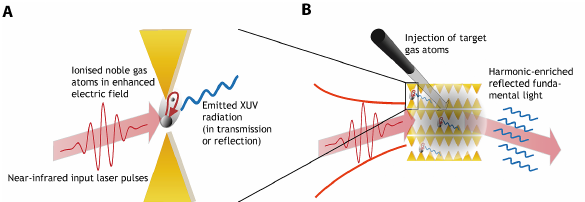
Figure 1: Scheme of HHG aided by plasmonic field enhancement (after [29]). a , An incident, near-infrared ultrashort laser pulse ex- cites a plasmon inside a bow-tie nano-antenna. Noble gas atoms, as commonly used in conventional HHG, experience the enhanced field between the tips of the triangles. b , When a large array of sin- gle bow-tie antennas is used, harmonics are generated at each “hot spot”, forming a maximum by constructive interference of all sources in the centre of the